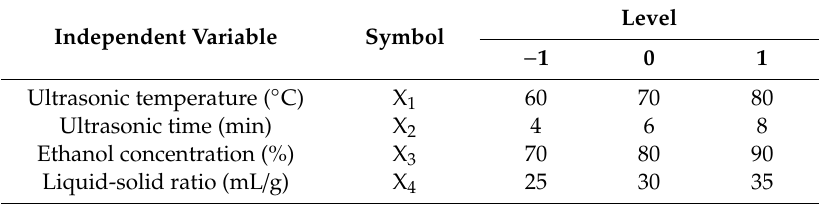
Table 4. Independent variables and their levels in Box–Behnken design (BBD).